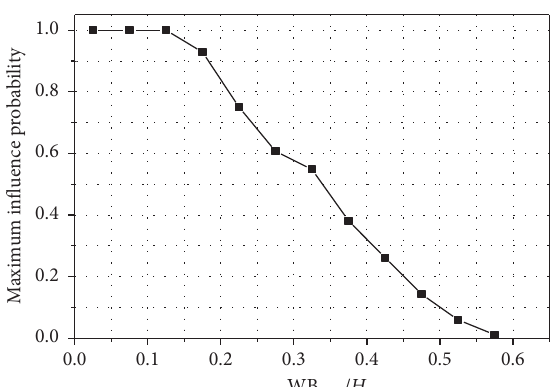
Figure 22: The maximum influence probability of the debris accumulation distribution along the Z axis under the continuous collapse of the masonry